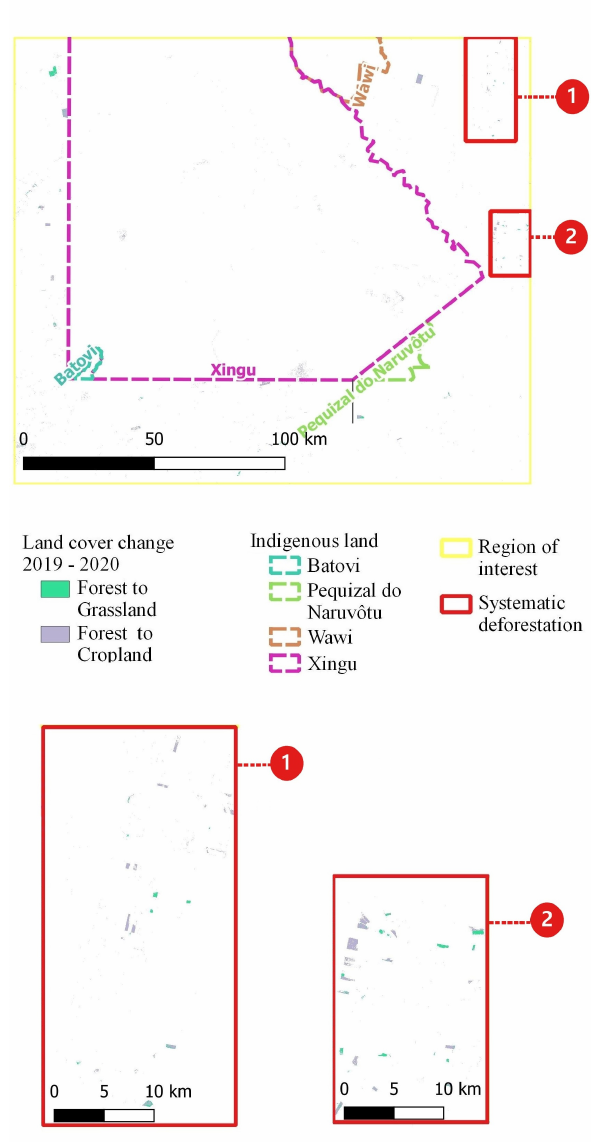
Figure 6: Land cover change – Forest to Cropland or